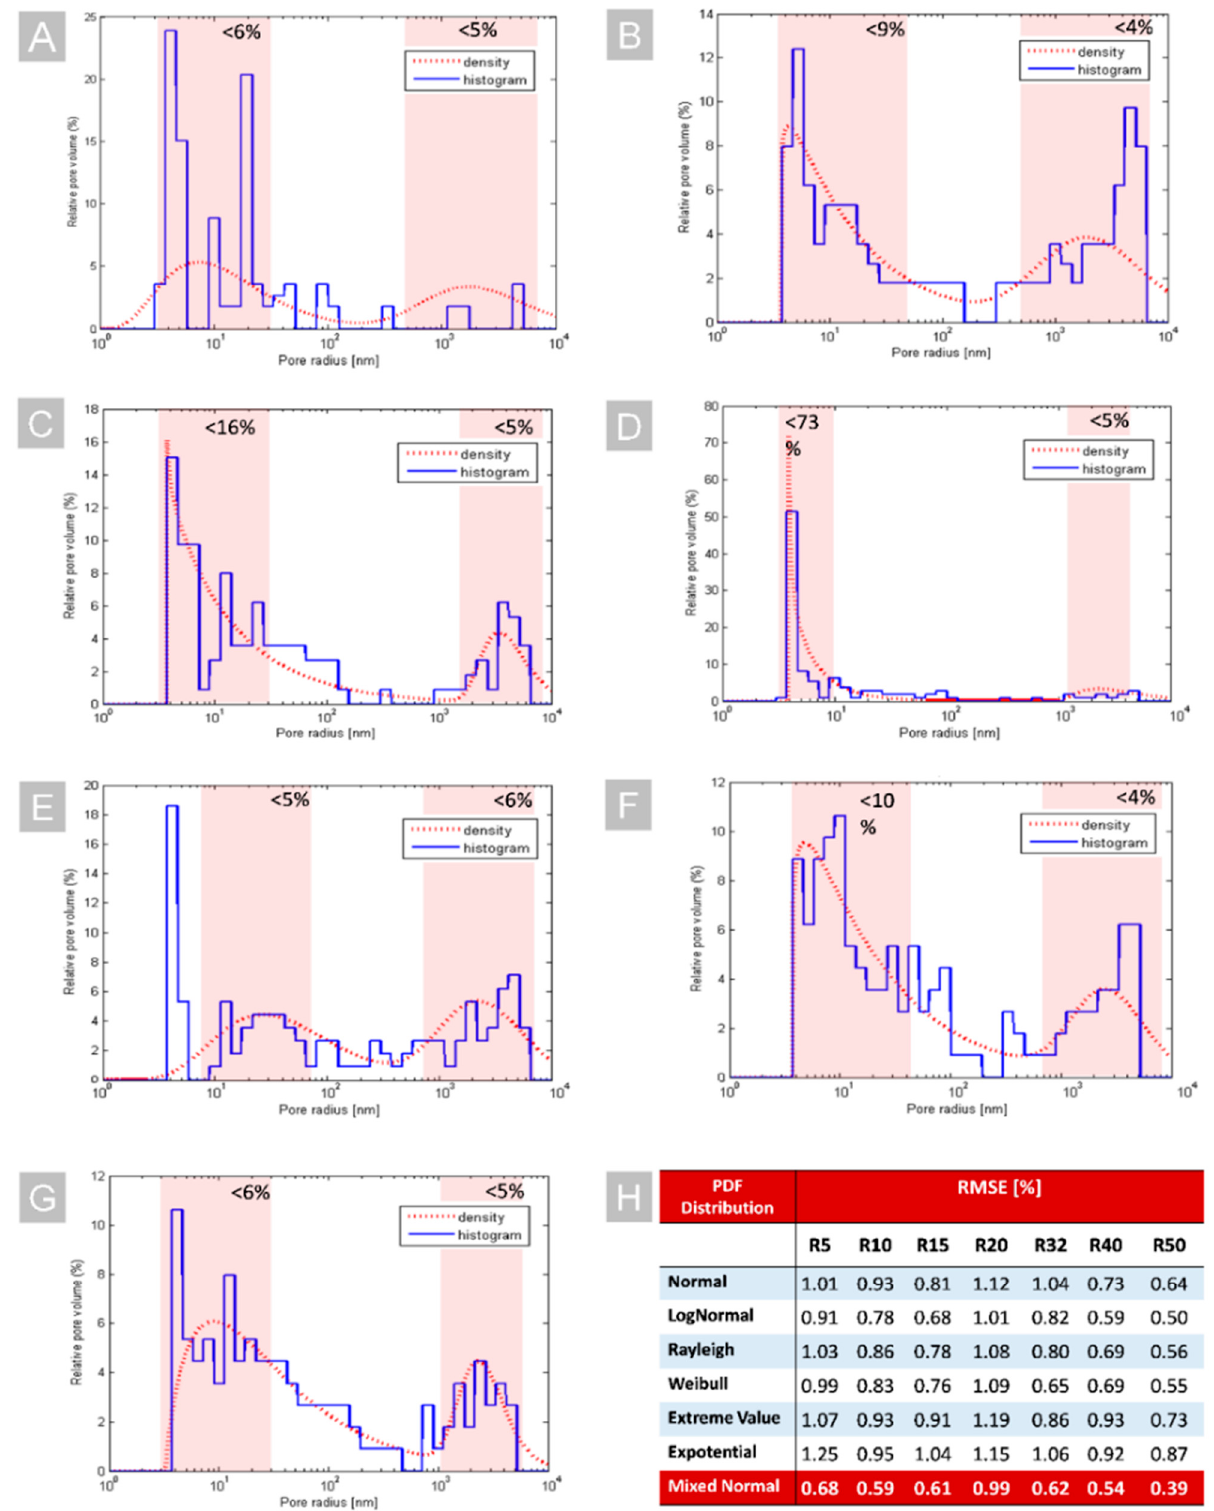
Figure 2. The pore radius distribution (histograms-solid blue line, PDF fitting-dashed red line) of different materials: R 5 ( A ), R 10 ( B ), R 15 ( C ), R 20 ( D ), R 32 ( E ), R 40 ( F ), R 50 ( G ), and the comparison of the goodness of the PDF fitting that was based on the used RMSE ( H ). The red regions represent the different fractions of pores with two predominant radius ranges.